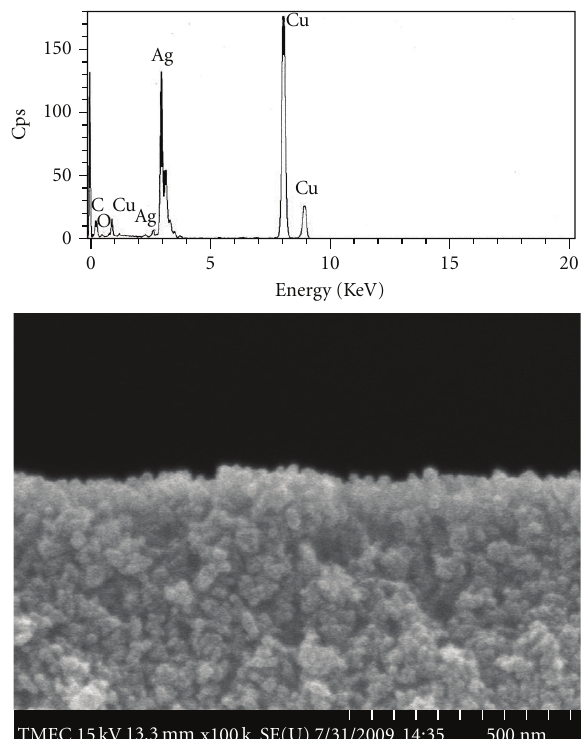
Figure 2: An SEM cross-sectional micrograph of the TiO 2 /Ag composite film with a UV exposure for 120 minutes. Inset shows an EDX spectrum indicating the presence of the Ag nanoparticles on the TiO 2